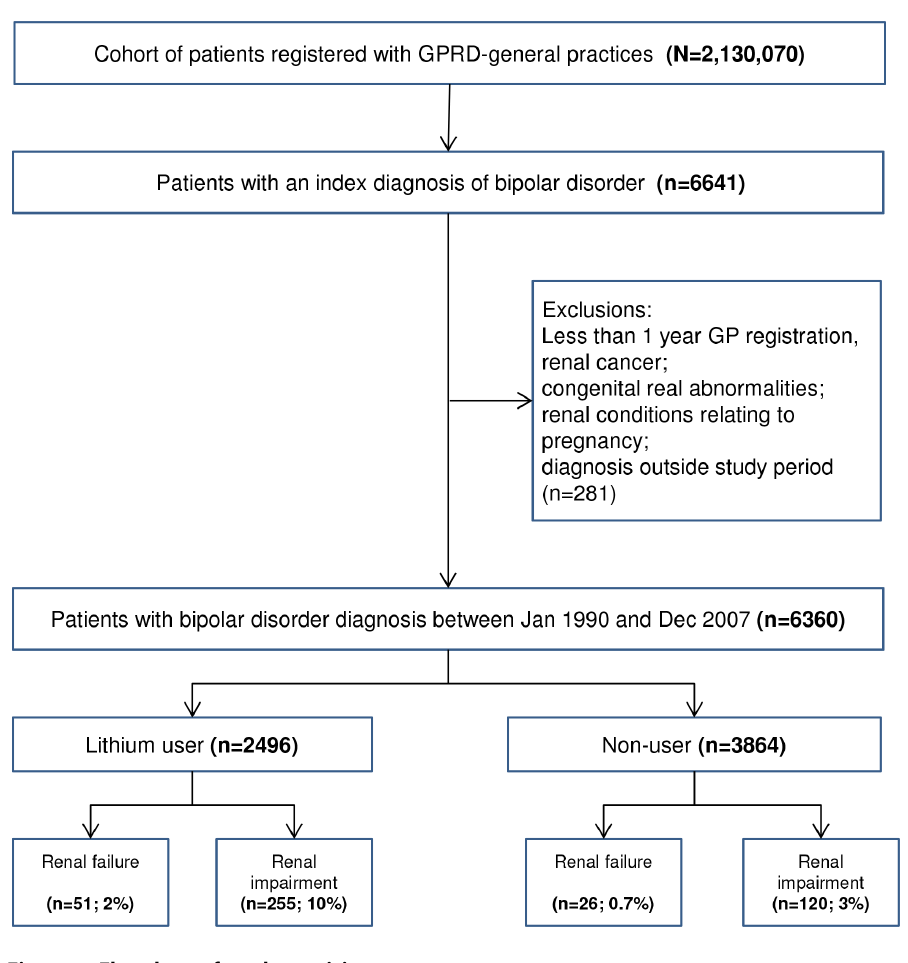
Figure 1. Flowchart of study participants.